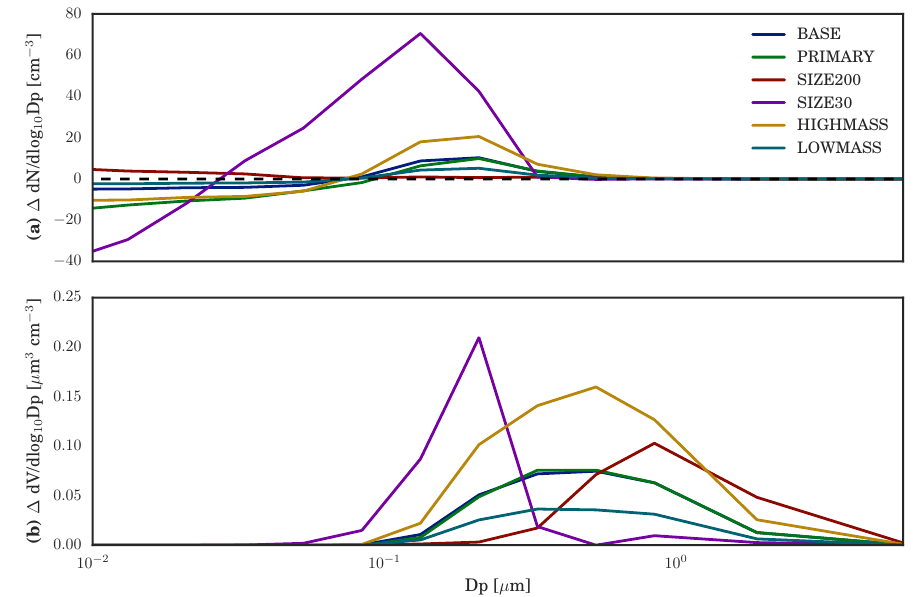
Figure 5. The change in global-mean (a) number distribution and (b) volume distribution for the different sensitivity studies relative to the WASTE-OFF